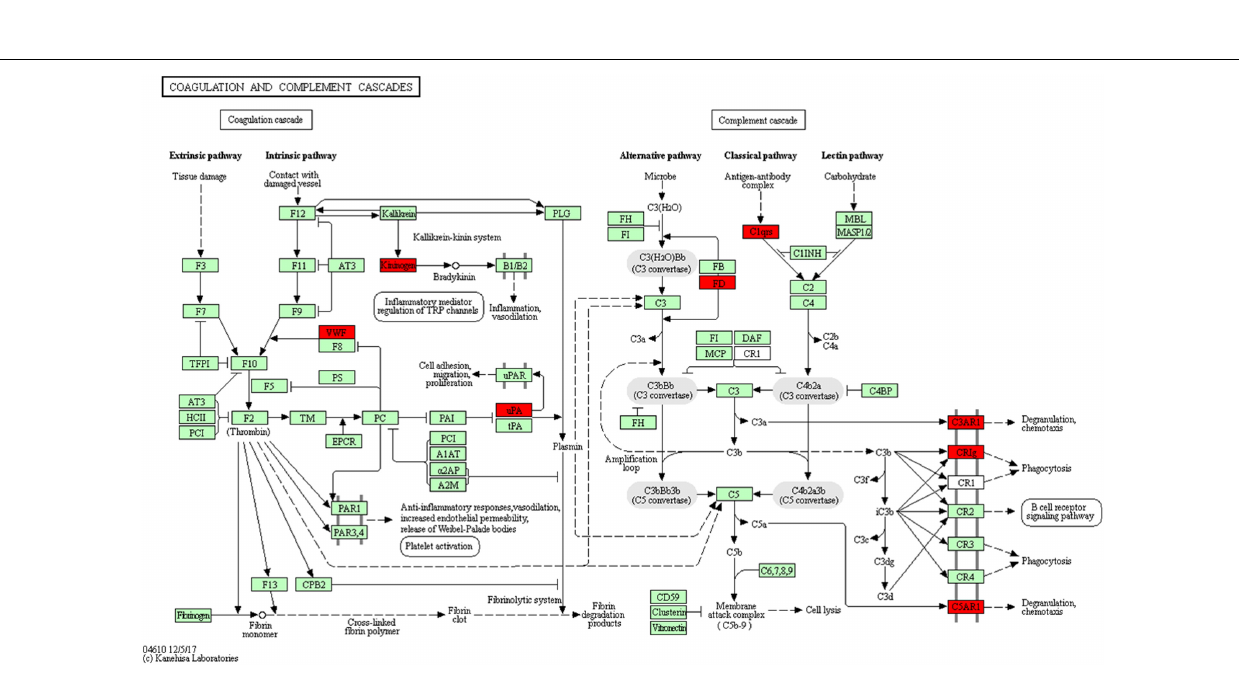
Frontiers in Pharmacology |